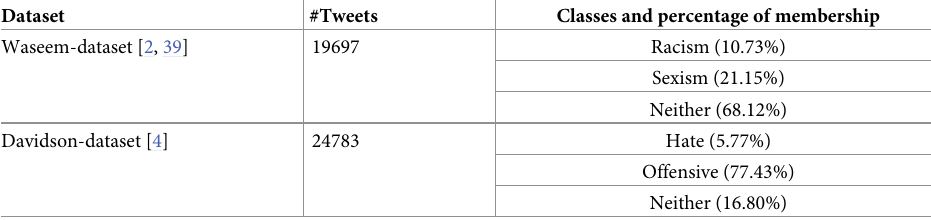
Table 1. Datasets description. The columns show the total number of tweets, the different categories and the percent- age of tweets belong to each one in the datasets, respectively. Dataset #Tweets Classes and percentage of membership Waseem-dataset [2,